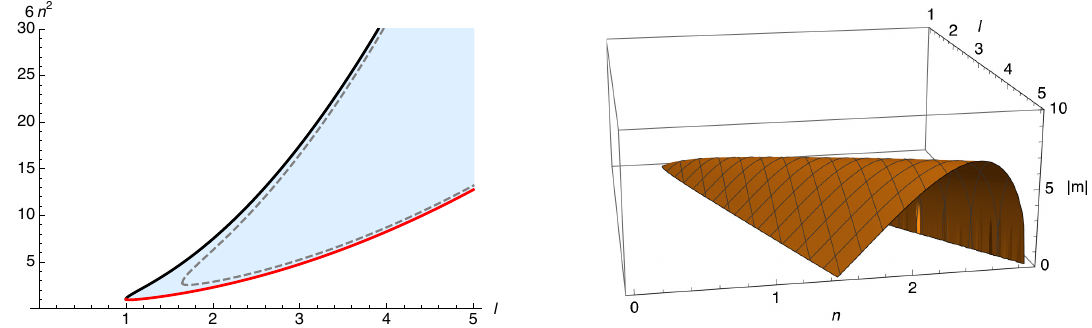
Figure 1 . Plots showing the restrictions in parameter space for the existence of a wormhole. The left panel shows in the ( l, 6 n 2 ) -plane, the region where the metric function f ( r ) has no zeroes and √ is positive definite. The upper (black) curve corresponds to 6 n 2 = l 2 + l l 2 − 12 X whilst the √ lower (red) curve to 6 n 2 = l 2 − 1 l l 2 − 12 X ; the dotted (gray) curves correspond to the Maxwell 2 case. In the right panel, only the region below the displayed surface corresponds to the permissible values for | m | . For illustrative purposes, we have set X := e − γ ( q 2 + g 2 ) = 1 / 12 and γ = 1 so that X Maxwell := q 2 + g 2 = e/ 12